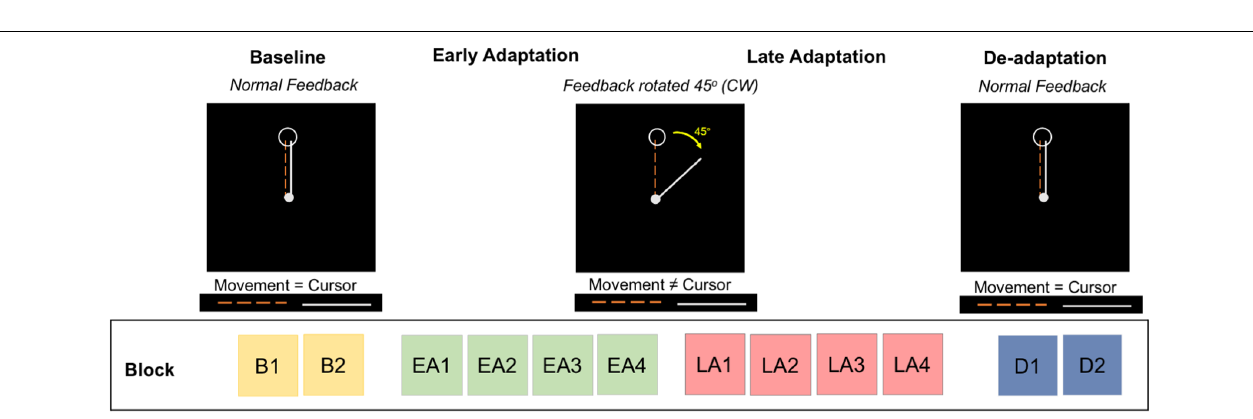
FIGURE 2 | Visuomotor adaptation task. The task includes four phases divided into multiple blocks: baseline (blocks B1, B2), early adaptation (blocks EA1, EA2, EA3, EA4), late adaptation (blocks LA1, LA2, LA3, LA4), and de-adaptation (blocks D1, D2). During baseline and de-adaptation, participants received normal visual feedback from the cursor. In the early and late adaptation phases, participants received a 45 ◦ clockwise (CW) rotation of the visual feedback; participants were naïve to this rotation.